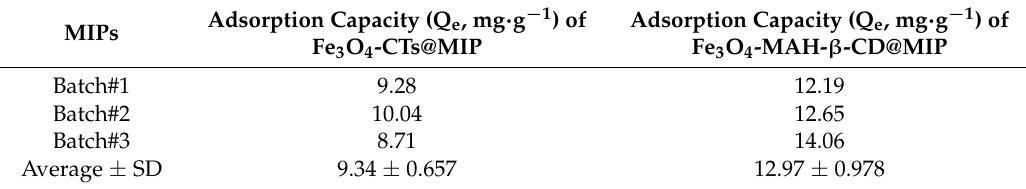
Table 3. Batch reproducibility of Fe 3 O 4 -CTs@MIP and Fe 3 O 4 -MAH- β -CD@MIP